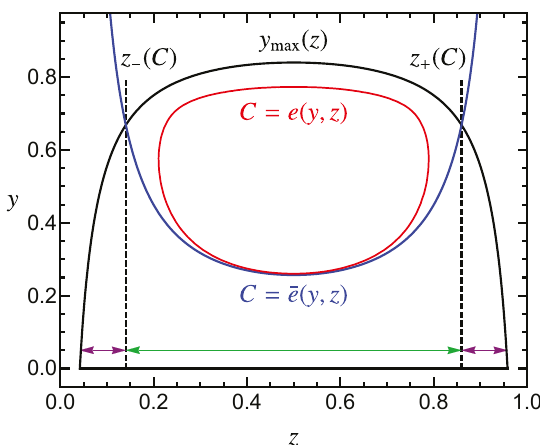
Figure 7 . Phase space diagram in ( z; y ) coordinates (black solid lines) showing a curve with constant value of the C-parameter event shape measurement function (red line) and its soft limit (blue line), using ^ m = 0 : 2, C = 0 : 42. The latter corresponds to eq. (3.24), which cuts the phase- space boundary at the points z (cid:6) ( C ). The dashed lines divide the y = 0 axis into three segments, marked with double-pointed